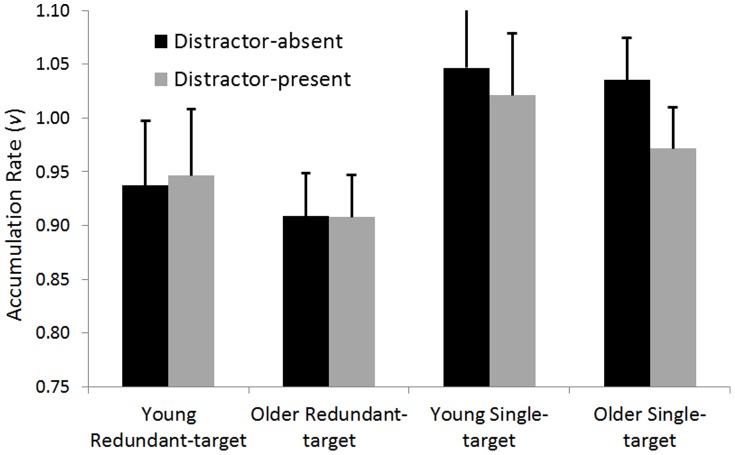
Accumulation rate parameters for the parametric model of the redundant target paradigm.The figure shows that in redundant-target trials, there are no effects for age and task-type. Yet in single-target trials, we observe a reduction in accumulation rates for older adults. Also note that accumulation rates for single-target trials are higher than for redundant-target trials, implying limited capacity.